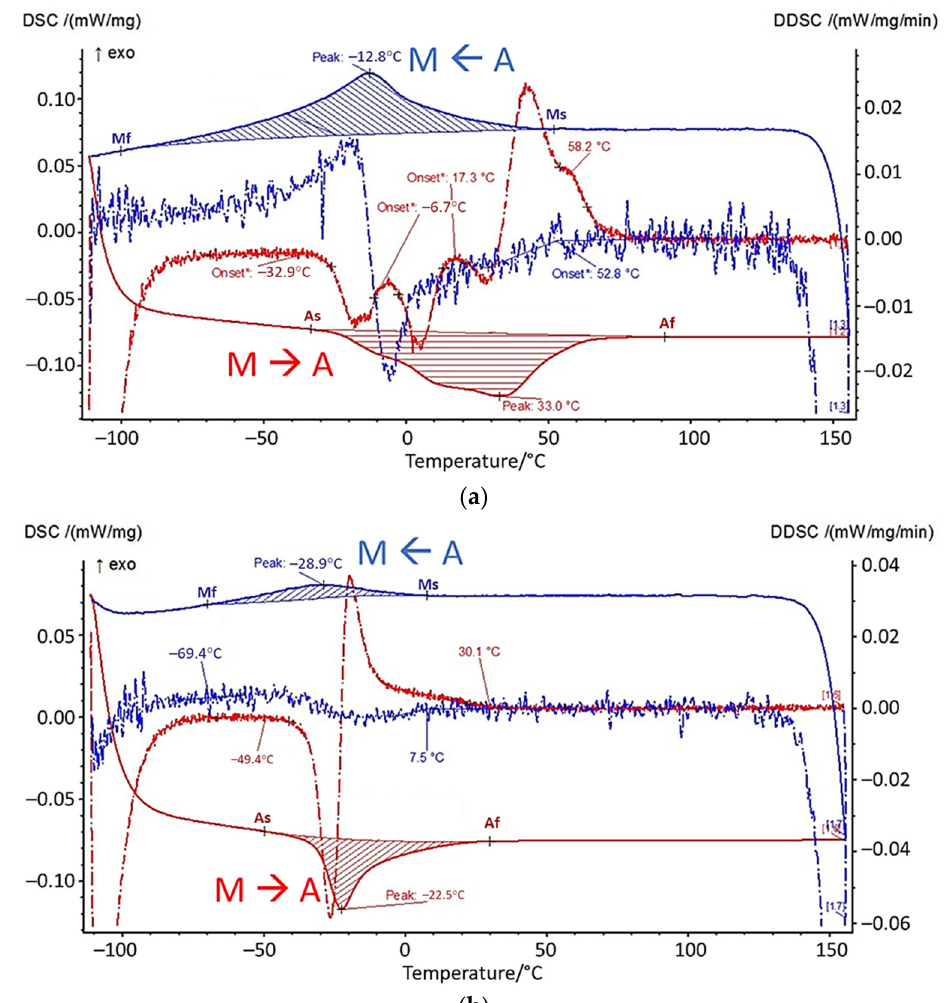
Figure 8. DSC measurements in the ( a ) as-sintered state, ( b ) after homogenization annealing and heat treatment at 550 °C for precipitation. Cooling is shown in blue, heating is shown in red.